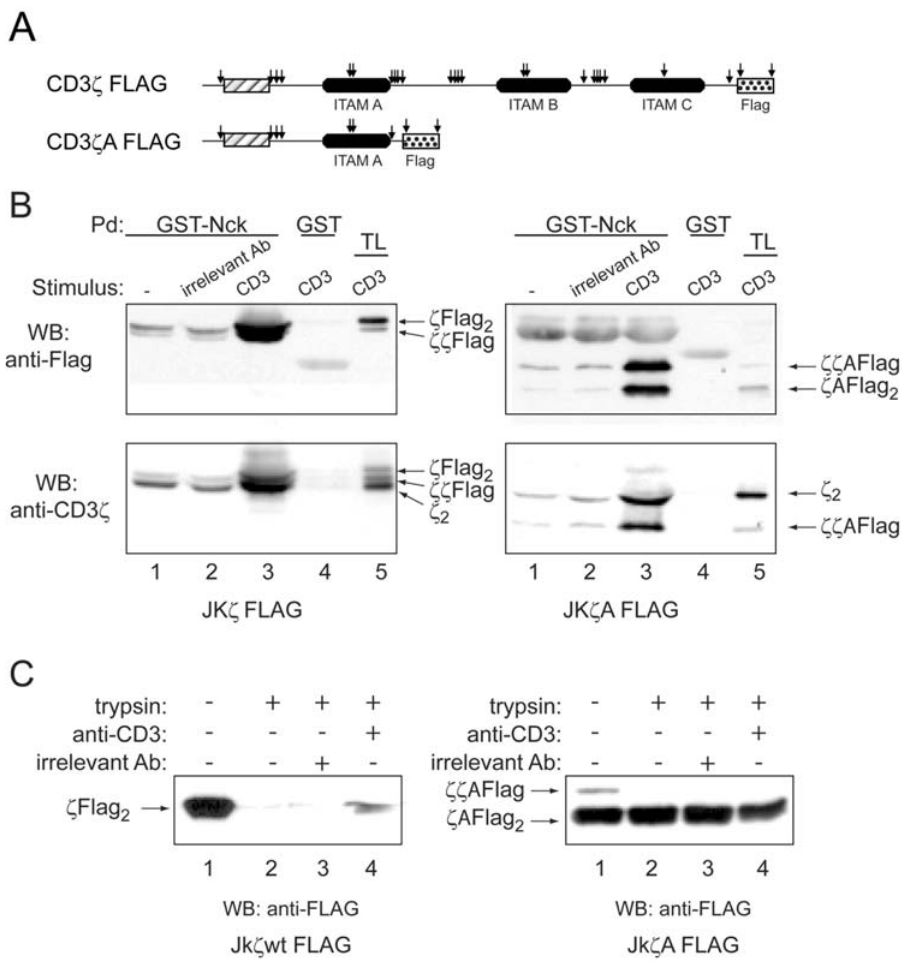
Figure 3. The membrane-proximal ITAM of CD3 f is constitutively protected from limited trypsin digestion. (A) Cartoon showing the potential trypsin cleavage sites in CD3 f and in a truncated CD3 f lacking ITAMs B and C. The position of a Flag epitope appended to the C-terminal end of both constructs is indicated. (B) The presence of f Flag or f AFlag does not alter the ligation-induced conformational switch in the TCR. GST- SH3.1 pull-down was performed as in Fig. 2C with lysates of Jurkat cells transfected either with f Flag (Jk f Flag) or f AFlag (Jk f AFlag). (C) ITAM A is constitutively condensed. Jk f Flag and Jk f AFlag were stimulated with antibodies and the lysates digested with trypsin as in Fig. 2C. Immunoblotting was performed with anti-Flag